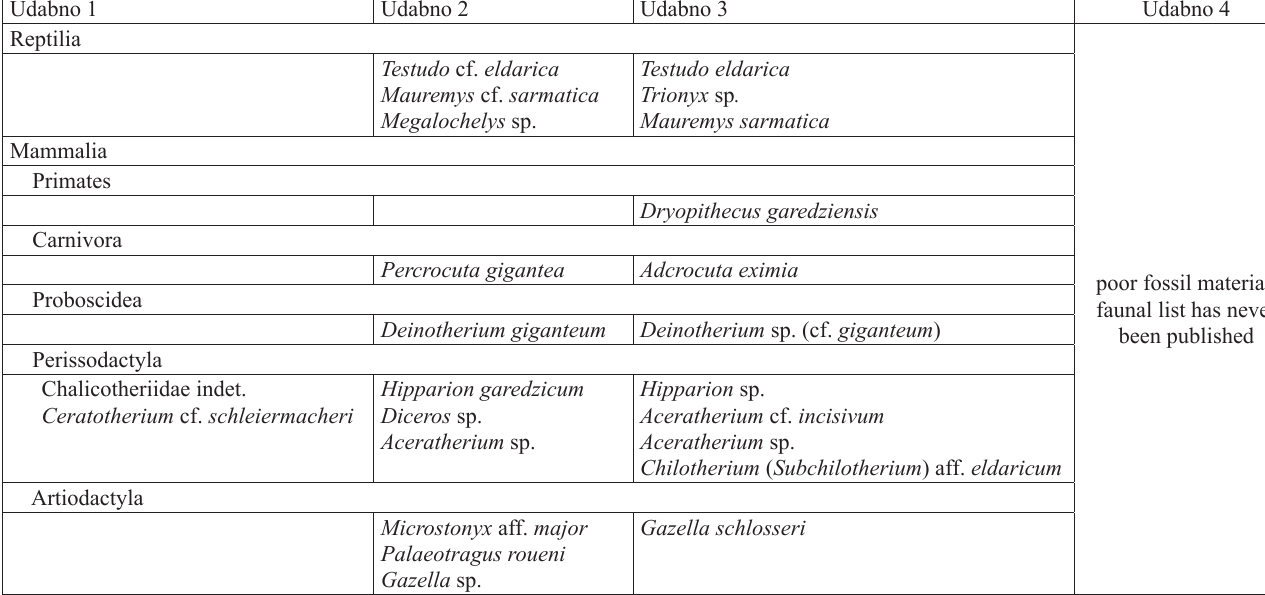
Table 5. Udabno faunal lists according to Tsikarishvili (1987); reptiles from Chkhikvadze and Amiranashvili (1996). Udabno 1